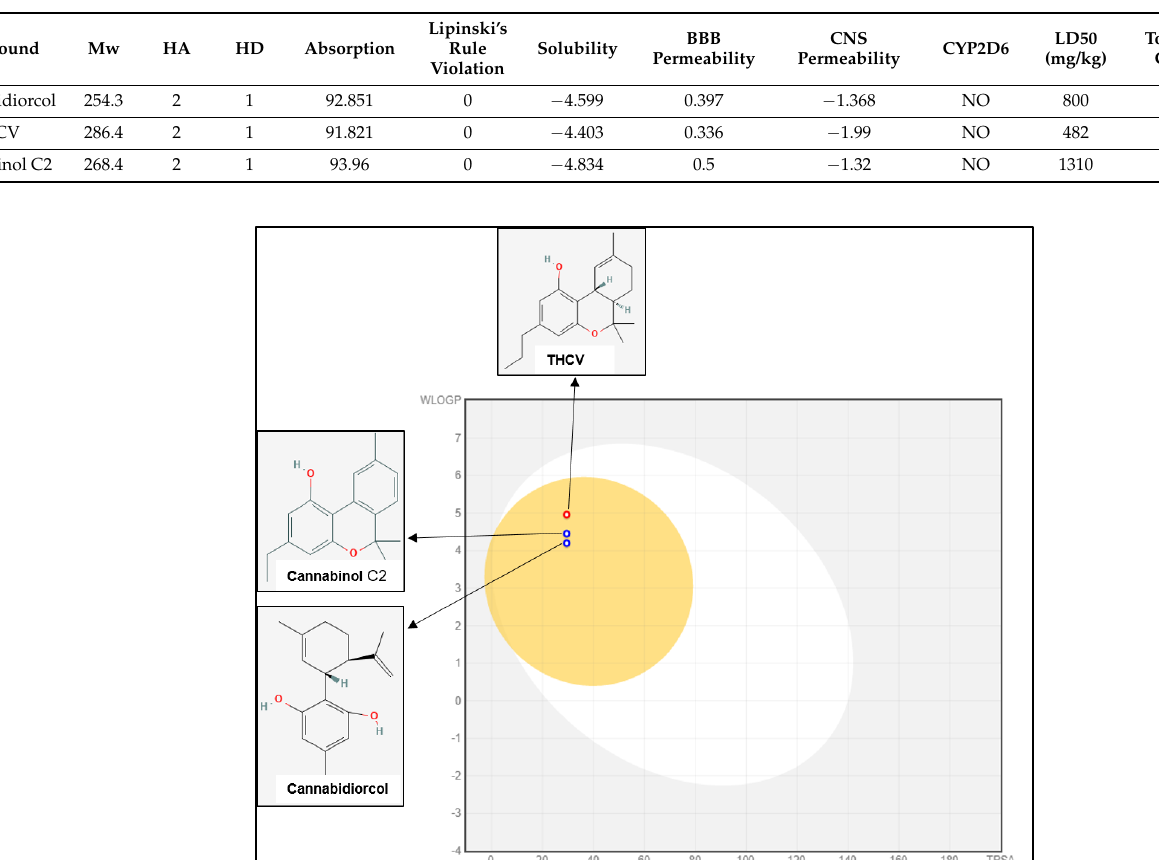
Figure 2. Predicted boiled-egg plot (Swiss ADMET) of THCV, Cannabinol C2 and Cannabidiorcol. The white region (HIA) predicts the physicochemical space of molecules that are able to be absorbed by the gastrointestinal system, while the yellow region (BBB) predicts the physicochemical space of molecules that are able to penetrate the brain. Table 2. Analysis of Pharmacokinetic properties and Protoxicity of three CBD analogues .